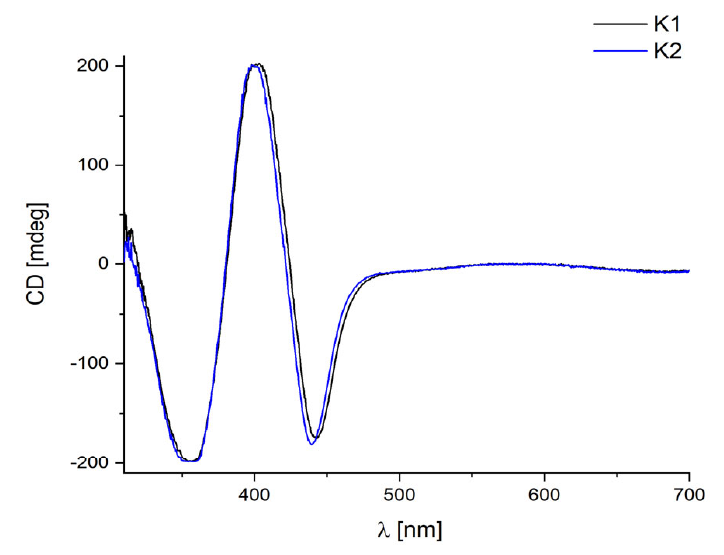
Figure 11. CD spectra of K1 and K2 in chloroform 1 × 10 − 4 M. The two studied complexes had similar CD spectra with the signals at 314